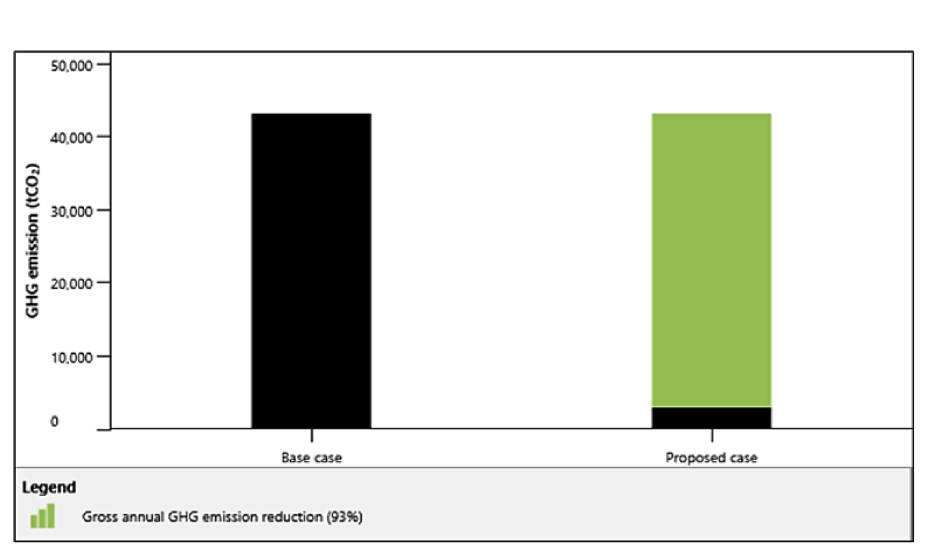
Figure 8. emissions comparison of thermo-electric plant via